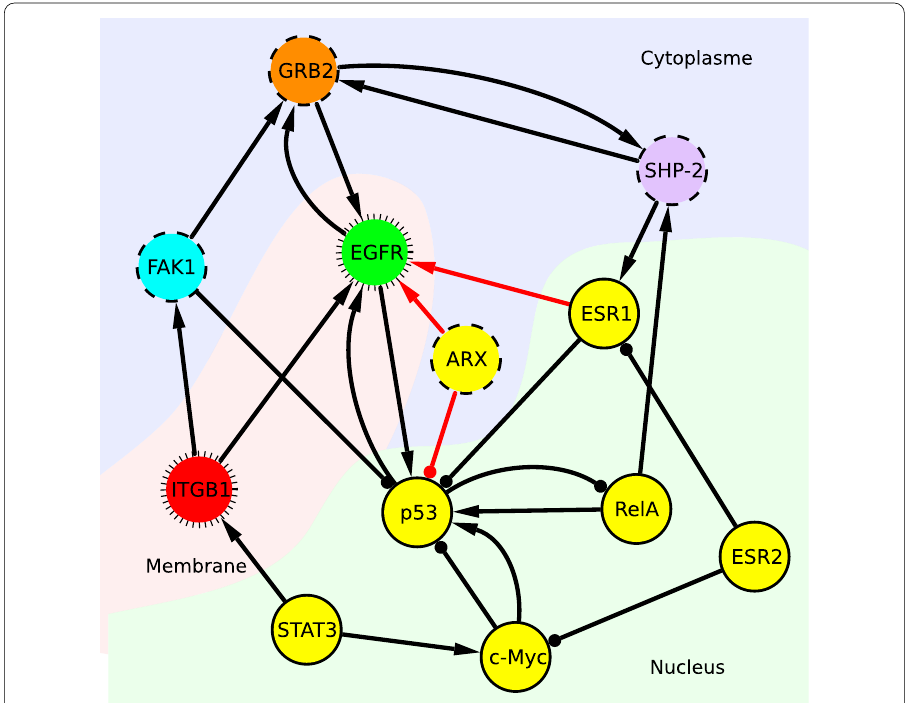
Fig. 6 Reduced network of the chosen twelve proteins (see Table 1). The construction procedure of this network is given in the main text. Arrow edges ( → ) represent activation links and dot edges represent inhibition links. The arrow tips and the dots are on the side of the target nodes. The black edges represent direct links. The red edges represent hidden links. The color of the nodes correspond to the type of proteins: transcription factors (yellow), protein kinase (cyan), generic receptor (red), receptor with enzyme activity (green), general binding protein (orange), and protein phosphatase (violet). The border style of the node correspond to the location of the proteins: nucleus (solid line), cytoplasm (dashed line), and plasma membrane (hairy